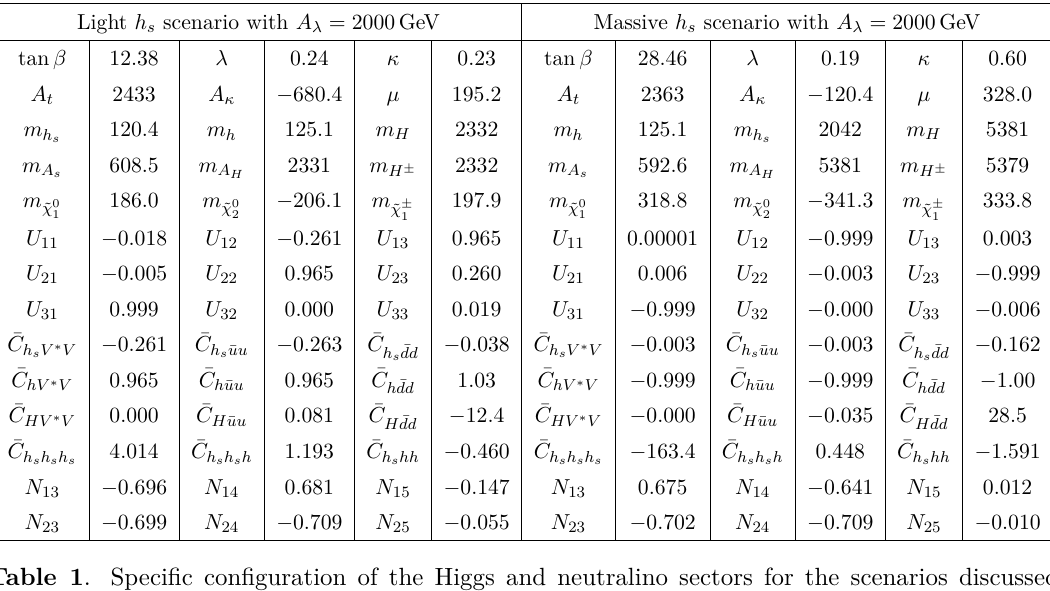
Table 1 . Specific configuration of the Higgs and neutralino sectors for the scenarios discussed in the text, and their prediction on the properties of the Higgs bosons and neutralinos such as the mass spectrum and the couplings of the Higgs bosons with different particles, ¯ C , which are ijk normalized to their corresponding SM predictions. Parameters with mass dimensions are in the unit of GeV. Other fixed parameters that are not listed in the table include m = 2000 GeV for flavor ˜ q universal soft-breaking masses of squarks, M = M = 2000 GeV and M = 5000 GeV for gaugino 1 2 3 masses, A = 0 for all soft-breaking trilinear coefficients except for A and A , and [ Y ] = 0 . 01 , i λ t ν 11 , 22 [ λ ] = 0 . 3 , and [ m ] = [ m ] = 2000 GeV for the parameters of the first two generations ν 11 , 22 ˜ ν 11 , 22 ˜ x 11 , 22 of the sneutrinos. All these parameters are defined at the scale Q = 1000 GeV . Besides, the Higgs masses and U are obtained by setting [ Y ] = [ λ ] = 0 , and sneutrino loop effects may slightly ij ν 33 ν 33 change them when varying the parameters in the sneutrino DM